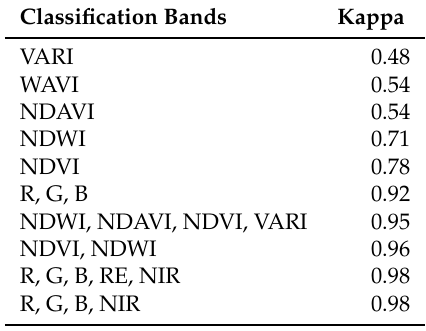
Table 7. Classifier accuracy with different input image band combinations.